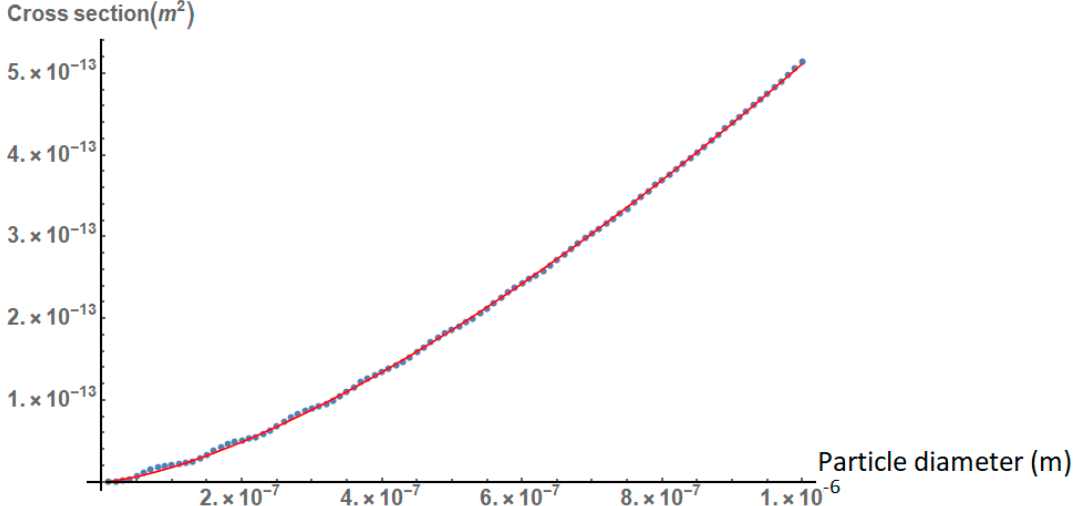
Figure 2. The absorption cross section of gold nanoparticles as a function of their diameter. The red